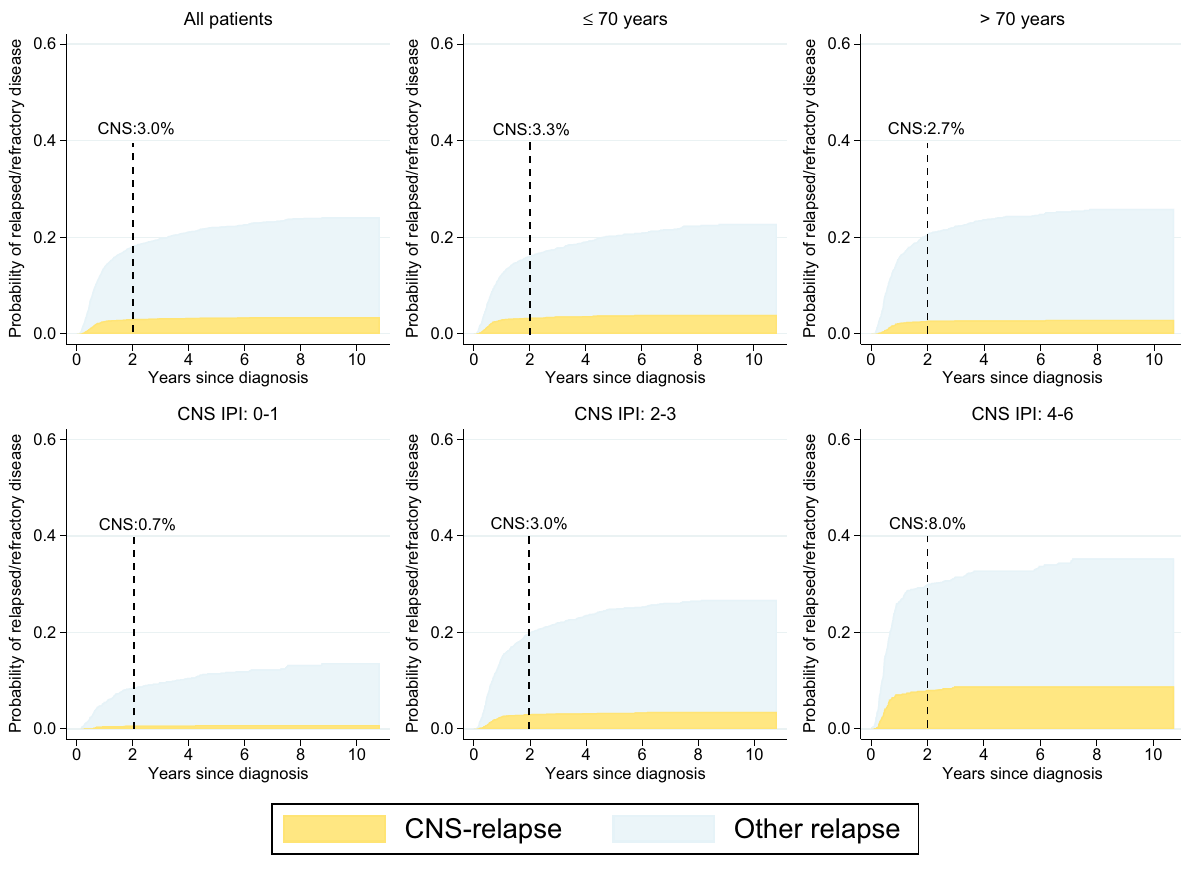
Fig. 4 Incidence of CNS relapse. Cumulative incidence of CNS relapse among curatively treated diffuse large B-cell lymphoma (DLBCL) patients overall (for whom detailed medical records were available, n = 3478, 118 events), and by age at diagnosis and CNS-IPI risk group, respectively (incidence assessed in the presence of the competing risks of relapse without CNS involvement and death*). Asterisk indicates not